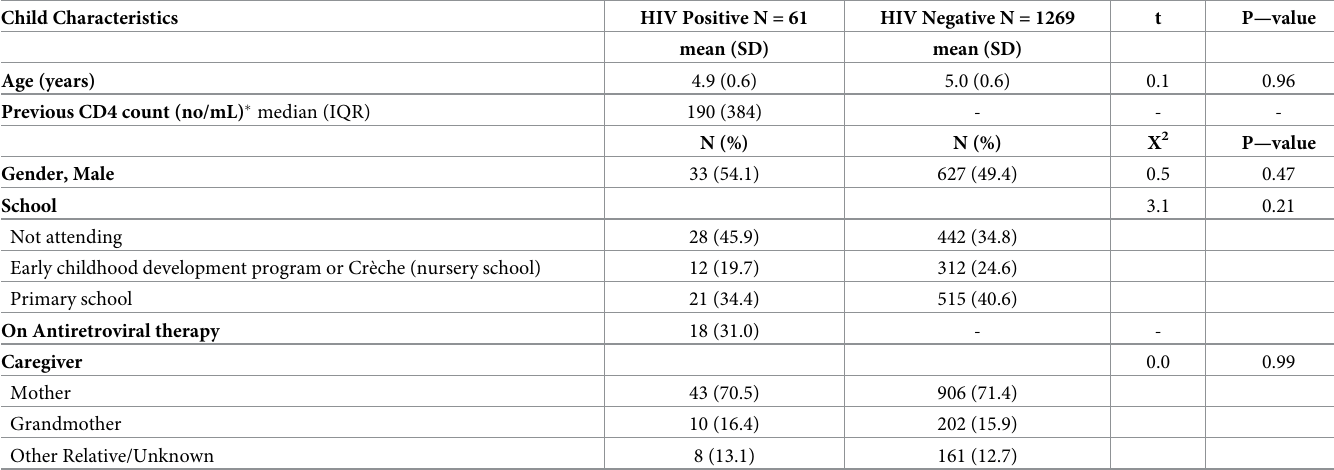
Table 1. Characteristics of subjects (N =